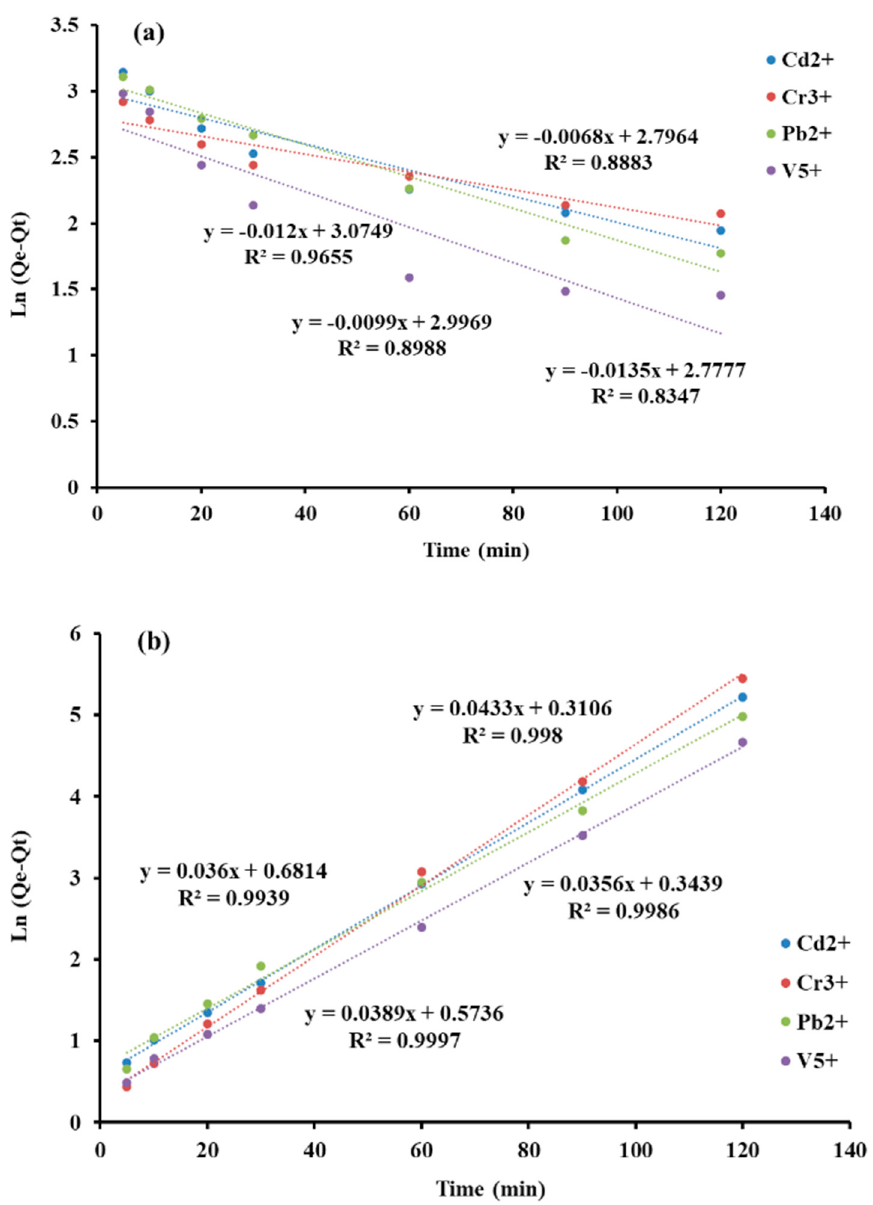
Figure 8. Kinetic models of pseudo-first order ( a ) and pseudo-second order ( b ). Table 1. Kinetic models and parameters for selected heavy metal ions.